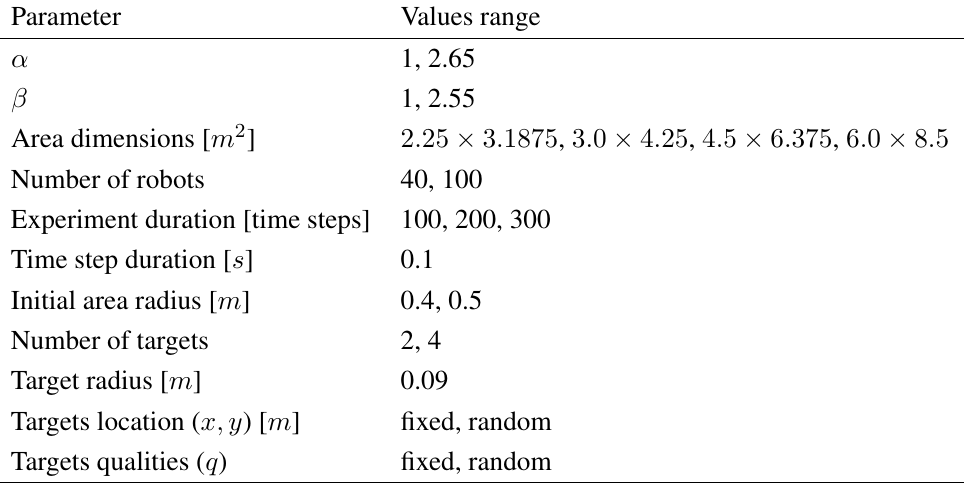
Table 2. Parameters describing experimental setups 2, 3, and